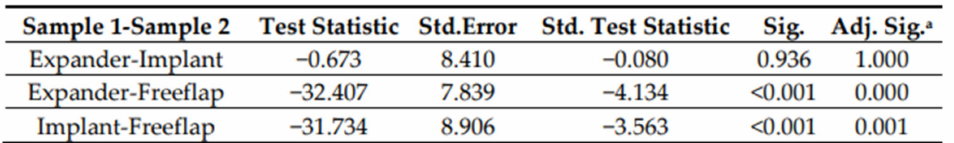
Figure 4. Pairwise comparison of implant, expander, free flap: each row tests the hypothesis that the level of blood loss between our groups are the same. A statistical significance can be seen in the comparison between “Expander-Free flap” and “Implant-Free flap”, showing that patients reconstructed with autologous tissue showed a significant drop in postoperative hemoglobin levels (significance level is 0.05).